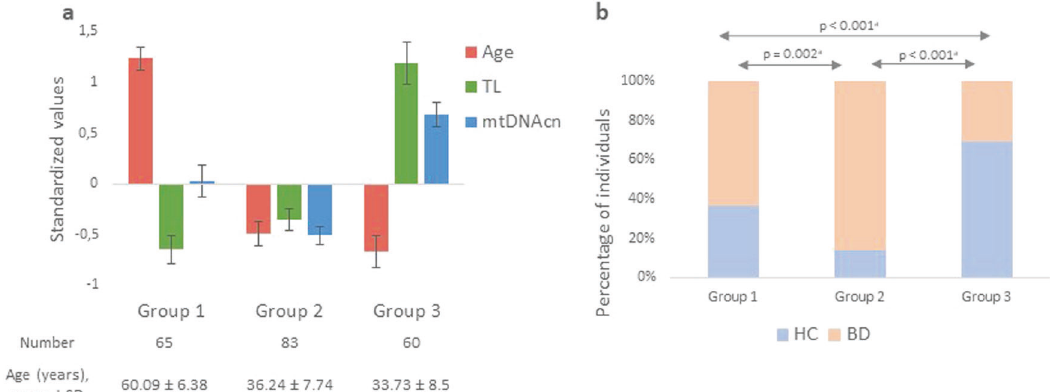
Fig. 3 Clustering of pooled BD and HC groups with age, TL, and mtDNAcn as clustering variables. Standardized values of age, TL, and mtDNAcn ( a ) are shown for each group created by the clustering analysis. Histograms ( b ) represent the percentage of HC and BD in each cluster. a Chi 2